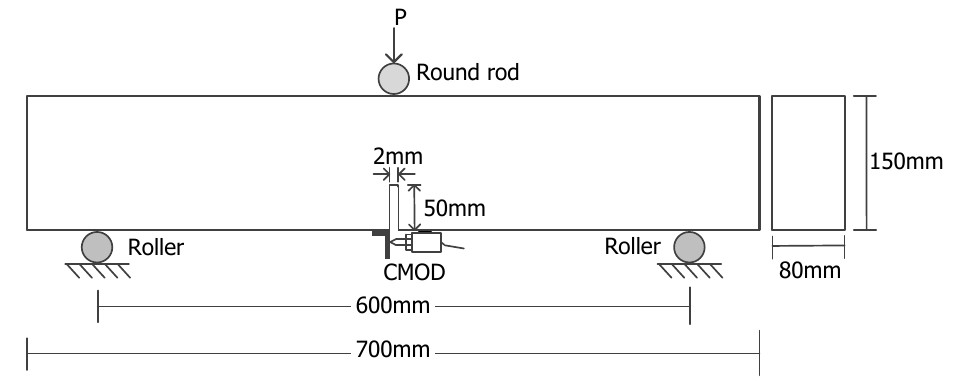
Figure 1. Set-up of the three-point bending test for the determination of the fracture energy of concrete. LVDT is the linear variable di ff erential transformer and P is the load.